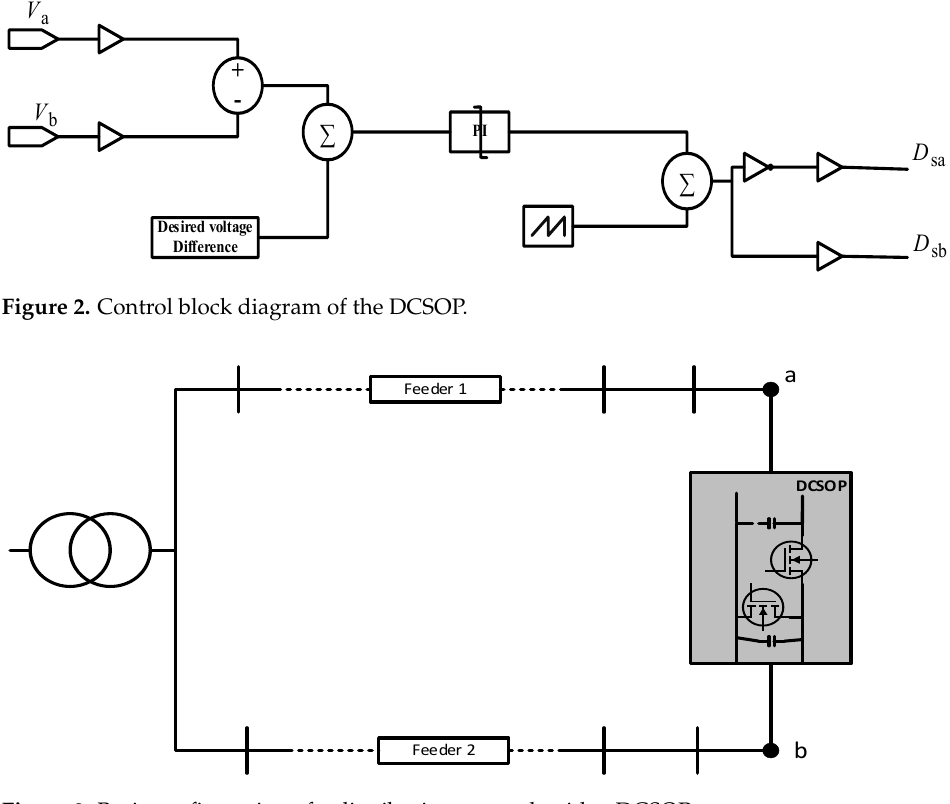
Figure 4. Main circuit topology: isolated bi-directional DC–DC converter based DCSOP. 1 C